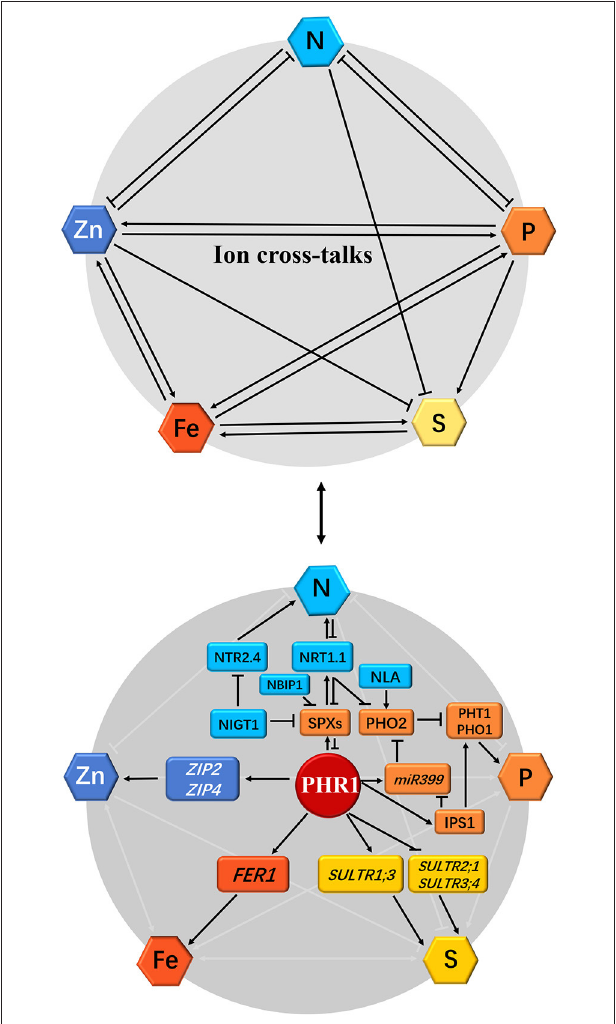
FIGURE 2 | Schematic representation of the effect of individual mineral deficiency on N, P, S, Zn, and Fe homeostasis and gene regulatory networks in plants. The interactions between nitrogen (N), phosphorus (P), sulfur (S), zinc (Zn), and iron (Fe) nutrient homeostasis are shown at the physiological level by arrows or flat-ended lines (the above panel). The single-direction arrows and flat-ended lines indicate the antagonistic and synergistic interactions, respectively. For the molecular bases of cross-talks among these five mineral nutrients, the phosphate (Pi)-starvation-induced transcription factor PHR1 acts as a potential integrator of N, P, S, Zn, and Fe nutrient signals in plants (the below panel): (1) During Pi deficiency, the activation of PHR1 induces Pi transporters PHT1 and PHO1 as well as Pi-starvation response genes SPXs, miR399, and IPS1 through both PHR1-P1BS and PHR1-miR399-PHO2 pathways, and represses PHO2, which interacts with the E3 ligase NLA to degrade Pi transporters, whereas PHR1 is inhibited by SPXs under Pi sufficiency. (2) N supply promotes PHR1 activity, however, SPXs expression is directly reduced under such a scenario by NIGT1 (Hu et al., 2019 reported that rice OsSPX4 is degraded in response to N supply by the interaction of OsNRT1.1B and OsNBIP1). Simultaneously, PHO2 expression is repressed in response to high N by NIGT1 and NRT1.1. Accordingly, N starvation leads to the decreased Pi uptake in plants due to the inhibition of PHR1 and accumulation of SPXs and PHO2. (3) PHR1 also serves as a transcriptional regulator of the sulfate transporters. (4) Plant Fe homeostasis is also